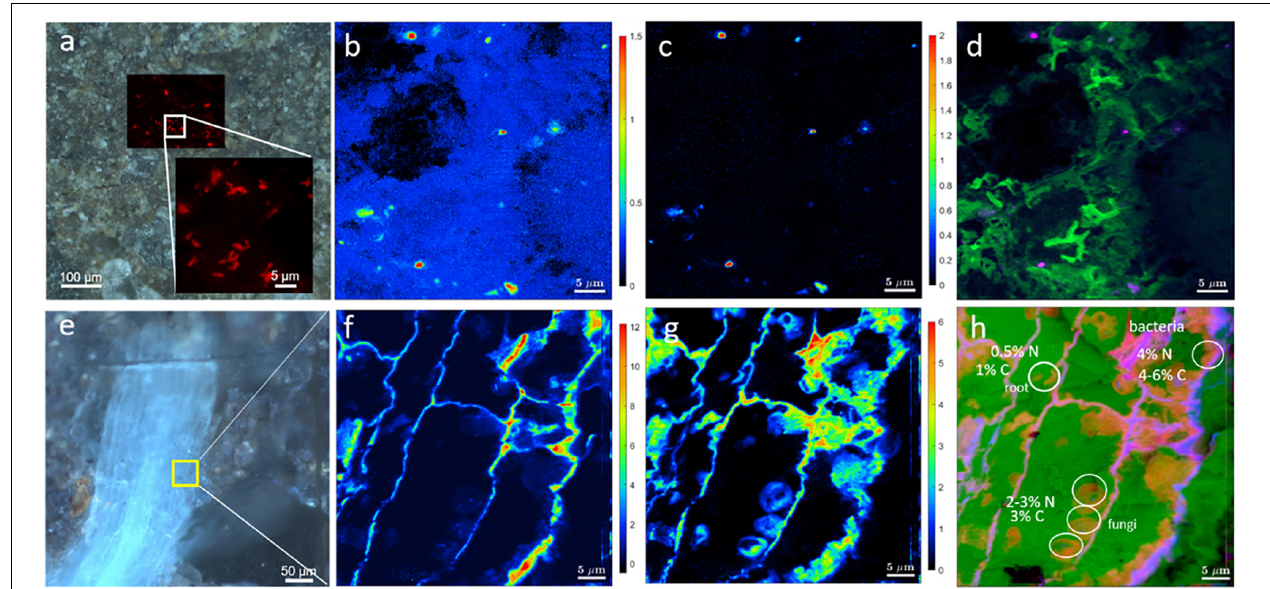
FIGURE 10 | Correlation of light microscopy with SIP-nanoSIMS showing C and N uptake by roots and bacteria. (a) CARD-FISH image of soil microbes overlaid with brightfield micrograph showing the location of microbial cluster in the resin-embedded rhizosphere sample. The inset in frame a depicts an enlarged CARD-FISH image of bacterial cluster. NanoSIMS imaging of soil bacteria (b–d) and root (f–h) . NanoSIMS analysis shows the relative assimilation of carbon (b) and nitrogen (c) within microbial cluster. (d) Log-scaled RGB-overlay of nitrogen assimilation (Red channel), CN − ion yield map as biomass intrinsic marker (Green channel) and carbon assimilation (Blue channel). (e) Epifluorescence image showing the root (blue) and adjacent minerals. The area analyzed by nanoSIMS is highlighted in yellow. Relative assimilation of carbon (f) and nitrogen (g) in the root. (h) Log-scaled RGB-overlay of assimilation activity (nitrogen in Red, carbon in Blue) with the intrinsic biomass marker (CN − ion yield map in